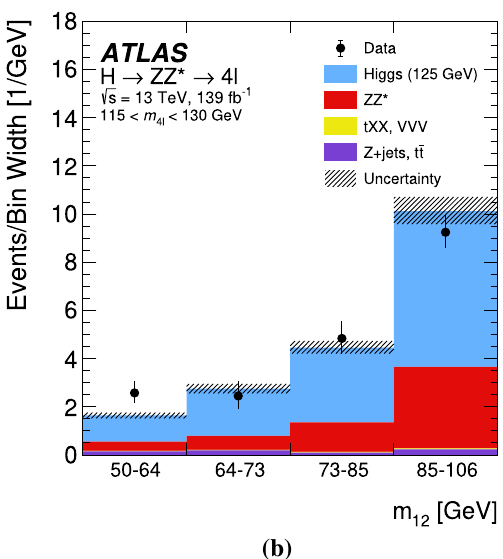
Fig. 4 The observed and expected (pre-fit) distributions of a p 4 (cid:3) m 12 , and c m 34 in the mass region 115 < m 4 (cid:3) < 130 GeV, for an integrated luminosity of 139 fb − 1 collected at Higgs boson signal with a mass m H = 125 GeV is assumed. The uncer-